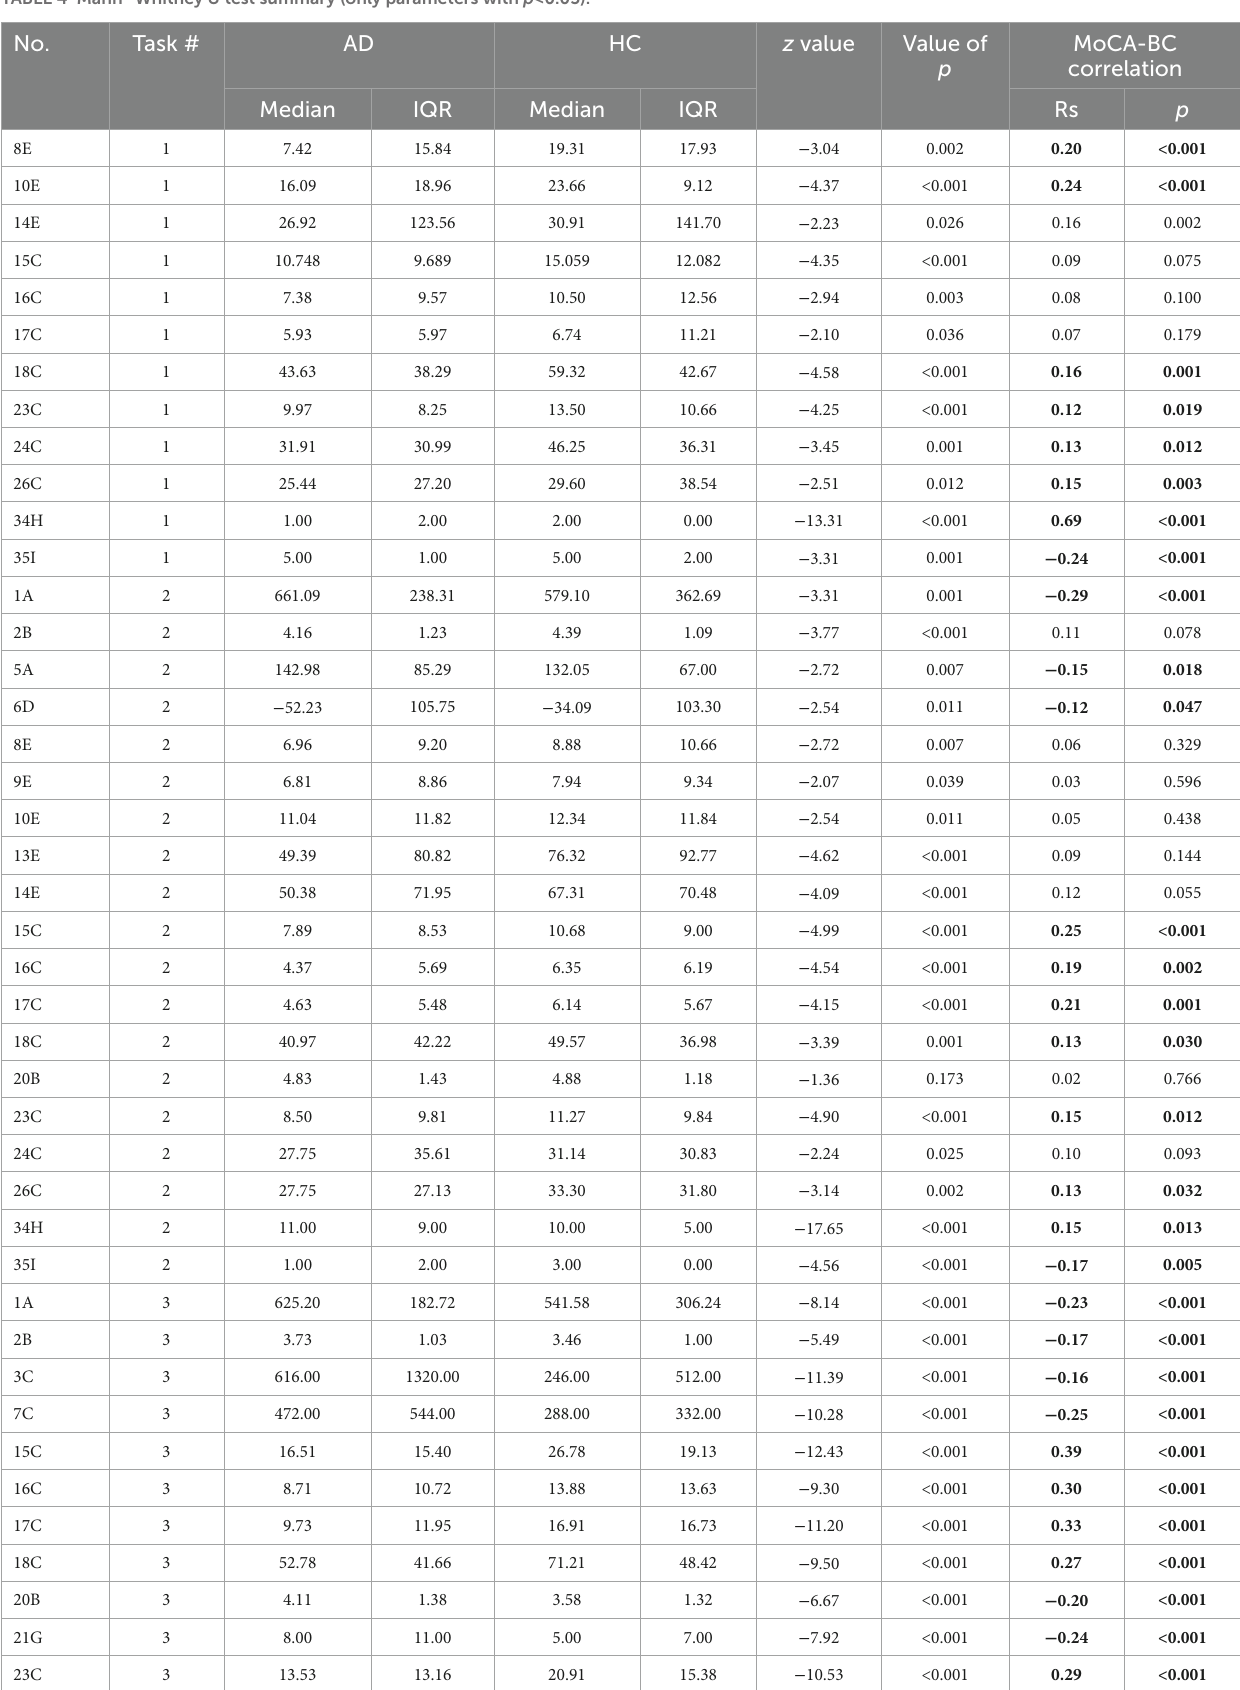
TABLE 4 Mann–Whitney U test summary (only parameters with p < 0.05).